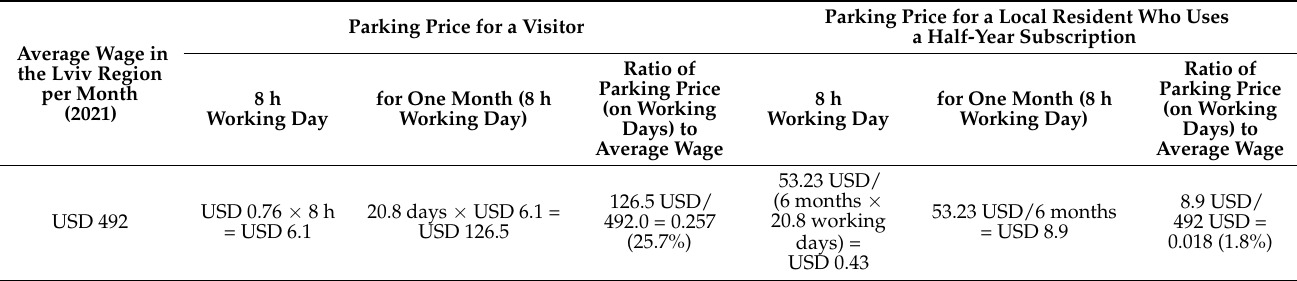
Table 4. Absolute and relative cost of parking in the study area for visitors and residents (1 parking space during the working day).